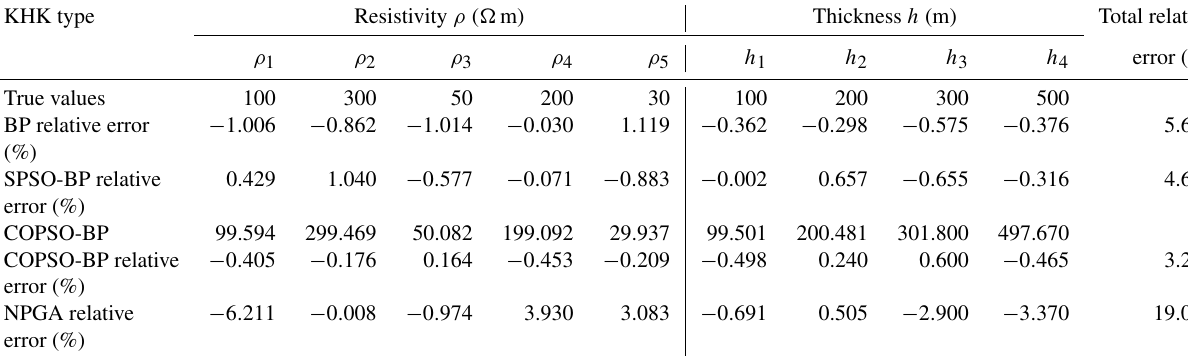
Table 4. Inversion comparison of five-layer KHK-type geoelectric models. KHK type